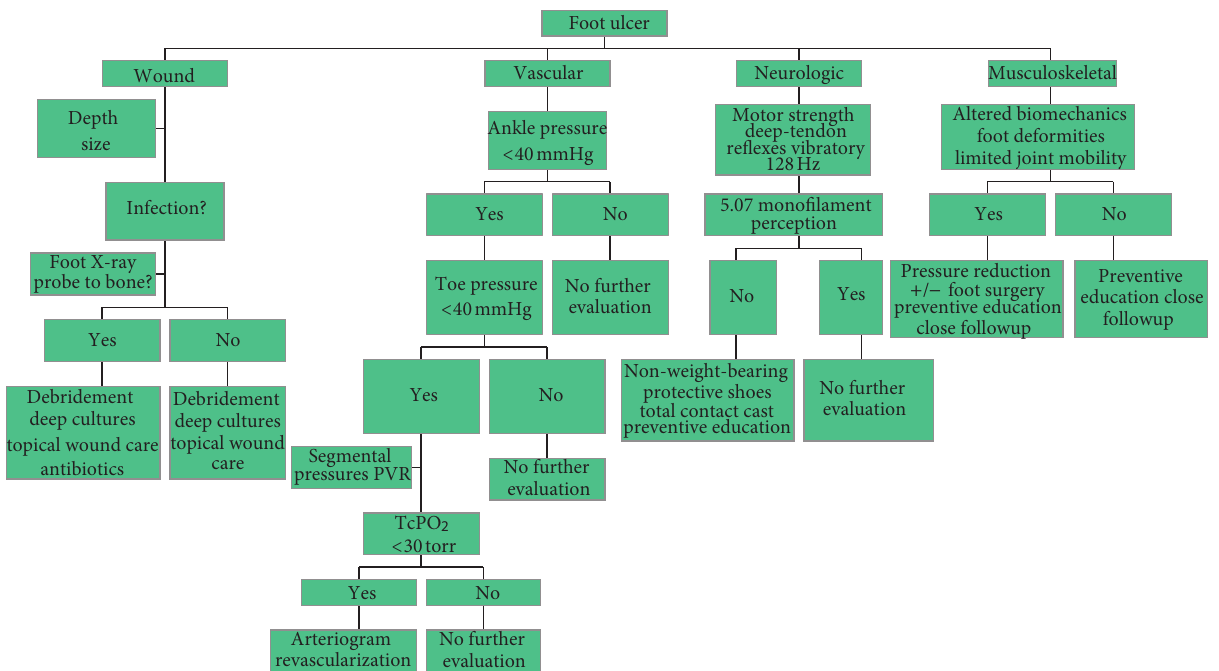
F 6: Sample algorithm for assessment and management of diabetic foot ulcers. e management of the diabetic foot is a complex clinical problem that requires multidisciplinary